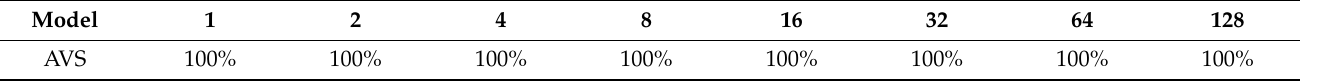
Table 1. Detection results of the AVS within the background with no